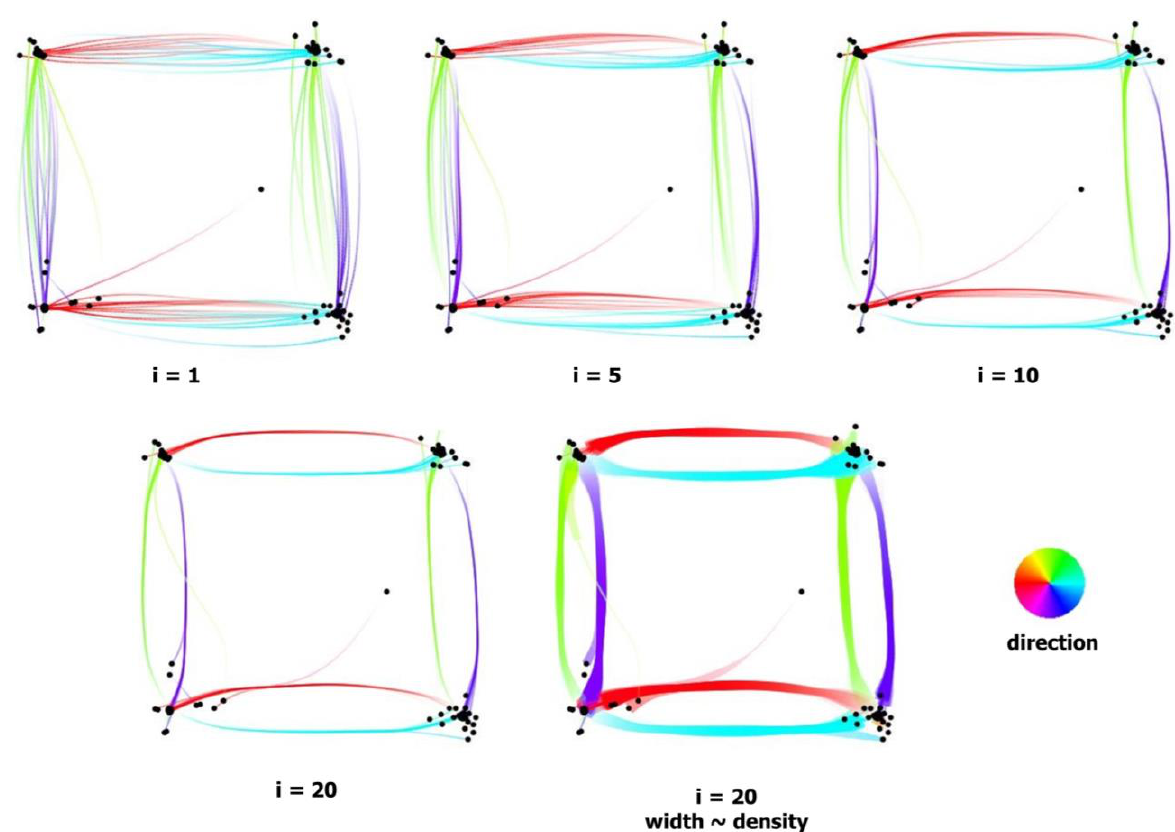
Figure 3. Bundling of saccades using the Attribute-Drive Edge Bundling algorithm (i = #iterations). Line width can be set proportional to the edge